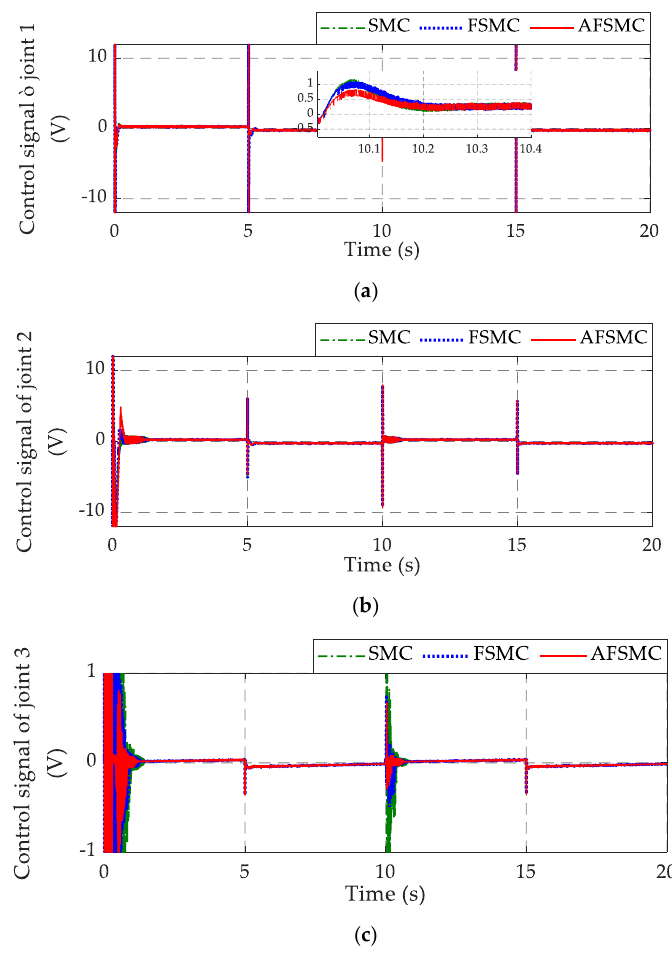
Figure 12. The control signal acting on the: ( a ) first joint, ( b ) second joint, and ( c ) third joint.